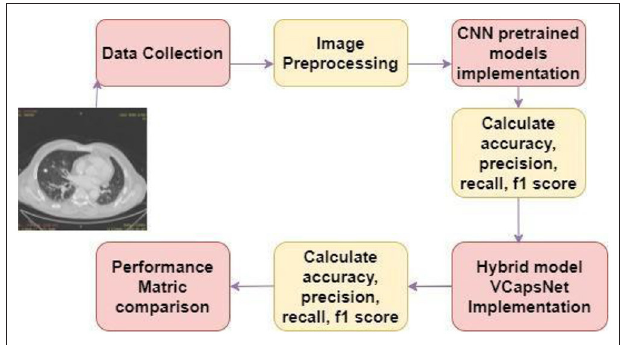
FIGURE 2 | Methodology.